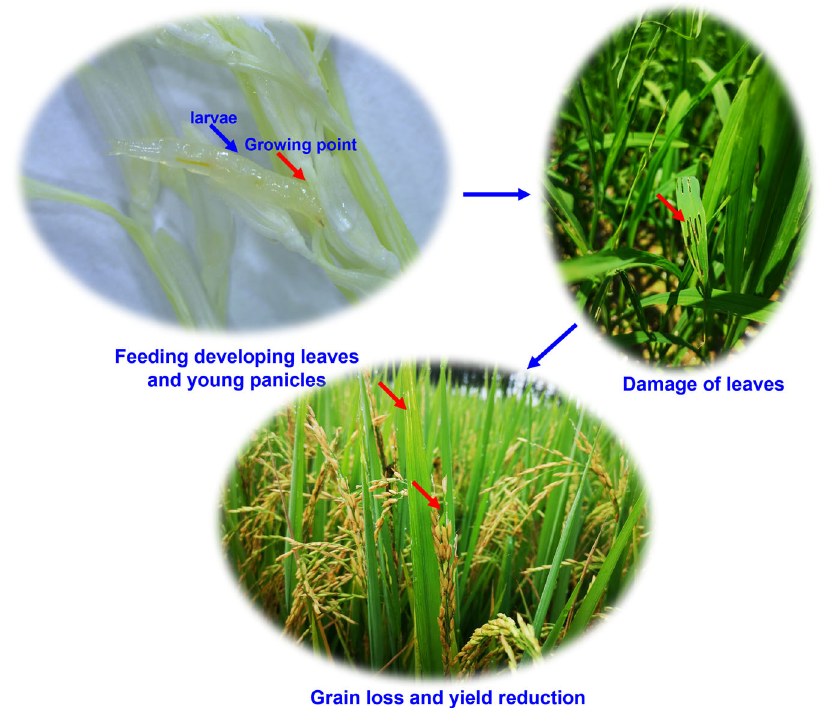
Fig. 1 Chlorops oryzae larvae damage to rice plants. Red arrow pointing to damage location (growing point, leaves and rice